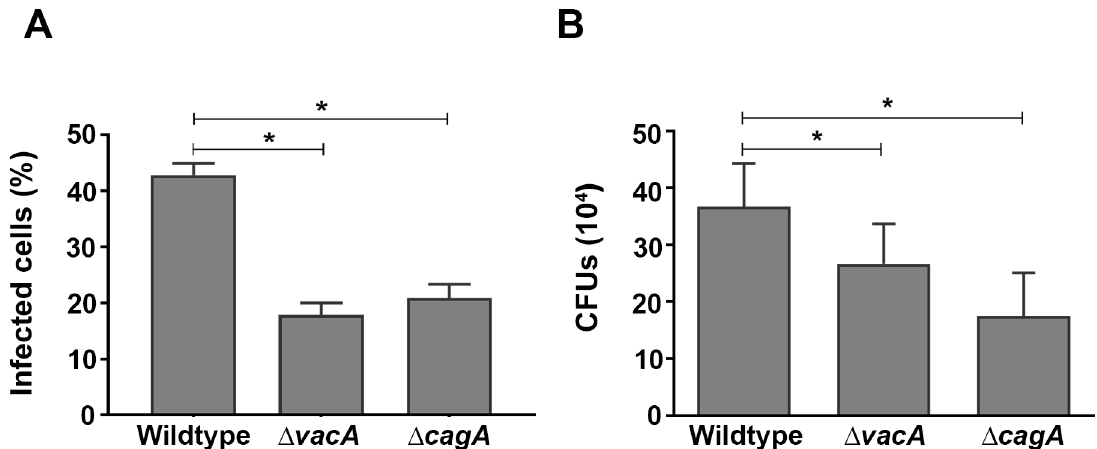
Fig 4. H . pylori uptake by AGS cells. (A) Flow cytometry was used to assess internalization of DiO-labelled bacteriafollowing infectionof AGS cells with H . pylori (MOI, 10:1) for 15 h. (B) Infected cells were treated with gentamycin for 2 h to kill any remainingextracellular bacteria. Quantitative assessment of viable H . pylori in AGS cells was by serial dilutionsof cells lysates. Results are ± SEM of three independent experiments. * , results are statistically different from those of cells infected with H. pylori wildtypestrain 60190 (P < 0.05), as determinedby one-wayANOVA with Tukey’s test for multiplecomparisons.